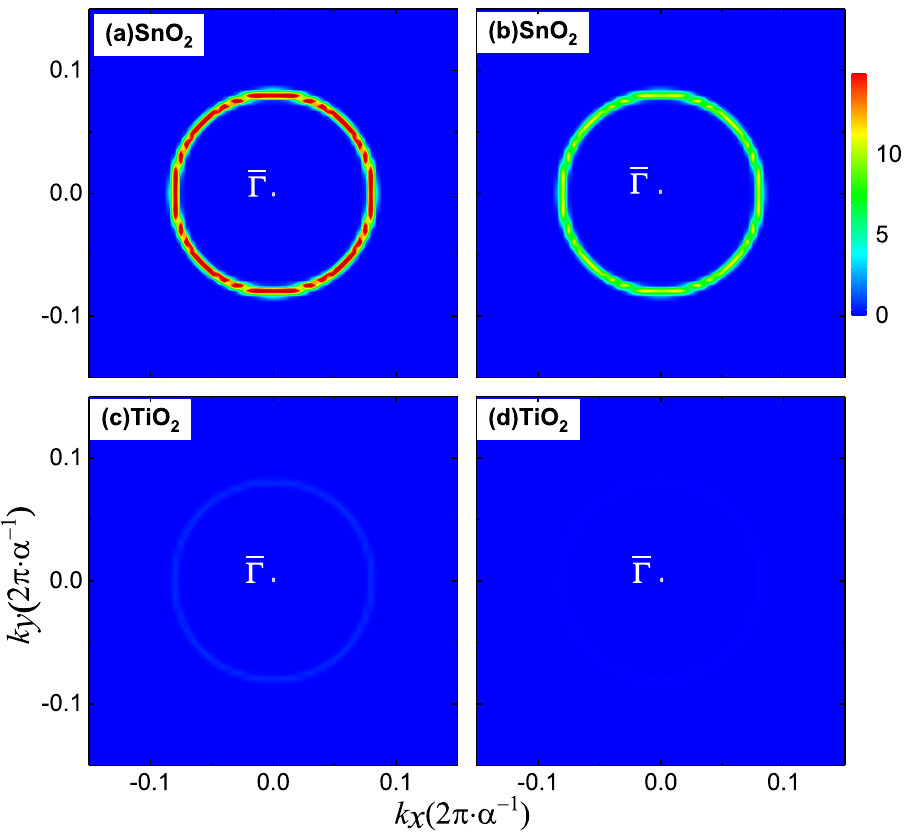
Fig. 3 Spectral density of states around the Γ point (k || = 0) at − 0.12 eV below the Fermi level. Projecting onto the left SnO 2 layer ( a ), the right SnO 2 ( b ), the right adjacent TiO 2 layer ( c ), and the right interface TiO 2 layer ( d ) for FTJ-3 with ferroelectric polarization pointing to the mechanism responsible for the TER effect in FTJ-1 and the polarization-controlled resonant tunneling mechanism responsi- ble for the TER effect in FTJ-2 could be well integrated in the elaborated FTJ-3 to work together and result in a giant TER with low resistance of ON state. Fig. 2a – f show the local density of states (LDOS) of the three FTJs projected on each atomic layer of the barrier with polarization pointing to the right and left as indicated by the red and blue arrows. Over all, we could see bands bending across the barrier in all structures due to the depolarizing fi eld whose direction depends on the polarization orientations. The positions of the conduction band minimum (CBM) re fl ect the shape of the tunneling barrier. In FTJ-1, the OFF state as shown in Fig. 2b with polarization pointing to the left, performs larger effective barrier height than the ON state with polarization pointing to the right as shown in Fig. 2a. At the BaTiO 3 /SrTiO 3 interface, since there are insuf fi cient screening charges, the potential in SrTiO 3 pinned to that at the interface with BaTiO 3 , thus forms an additional fl at ef fi cient potential barrier which reverses with ferroelectric polarization orientations and leads to larger effective barrier height of the OFF state 15 . In FTJ-2 for the OFF state as shown in Fig. 2d with polarization pointing to the left, the CBM of each layer is above the Fermi level. For the ON state as shown in Fig. 2c with polarization pointing to the right, the CBM of the BaSnO 3 atomic layers bends below the Fermi level and serves as an effective quantum well which would provide resonant states and result in resonant tunneling 28 . In FTJ-3, for the OFF state as shown in Fig. 2f with polarization pointing to the left, the whole electronic structure is similar as the OFF state of FTJ-1 as shown in Fig. 2b. Speci fi cally, the SrTiO 3 and BaSnO 3 layers form additional fl at